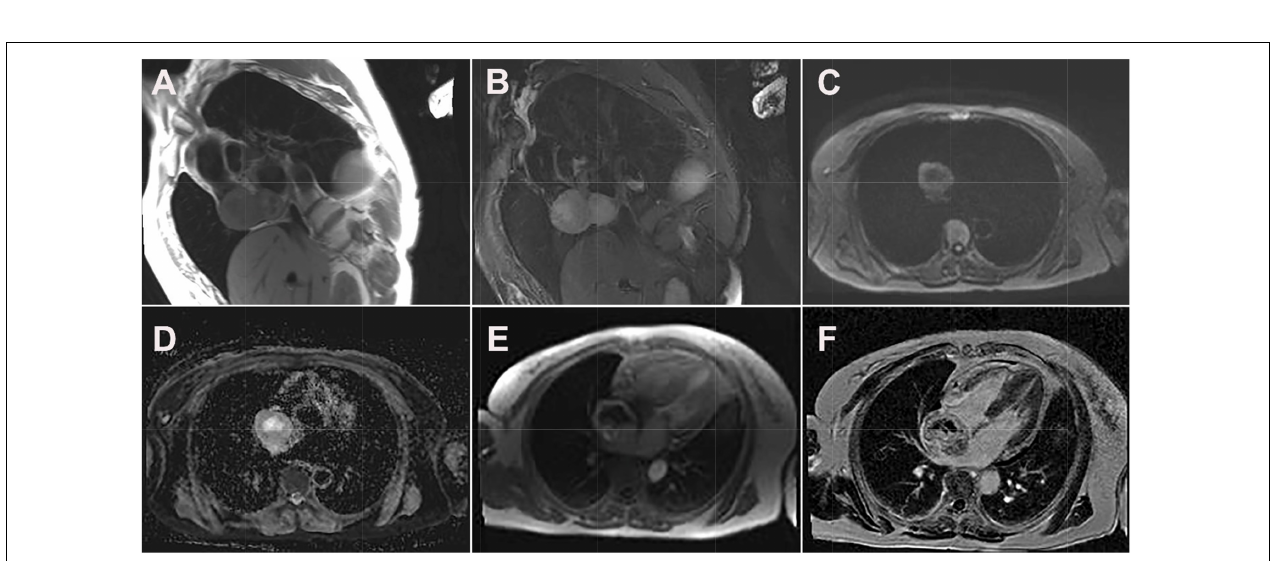
FIGURE 3 | Cardiac magnetic resonance images of cardiac paraganglioma. (A) T1-weighted image; (B) T2 fat-suppressed image; (C) diffusion-weighted imaging; (D) apparent diffusion coefficient image; (E) first-perfused image; (F) delayed scans image.